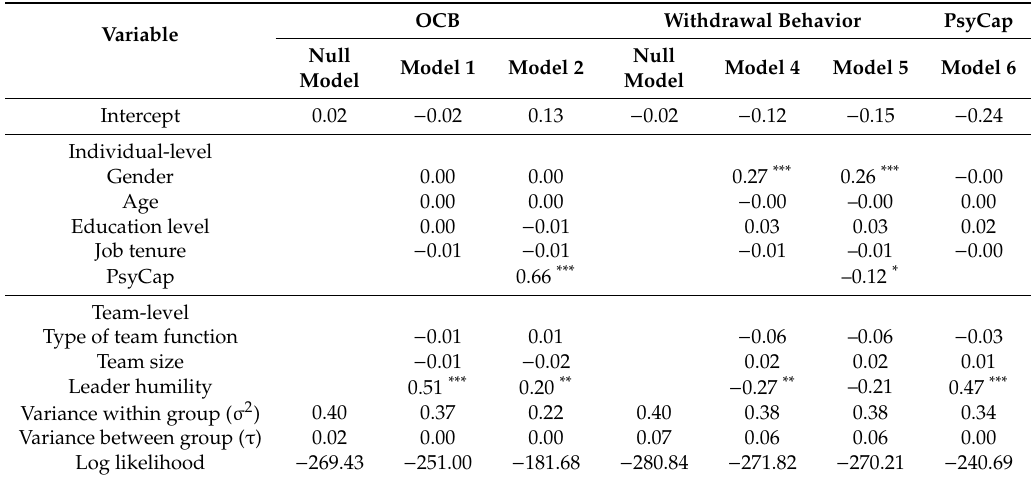
Table 3. Hierarchical linear modeling (HLM) results of the hypothesized